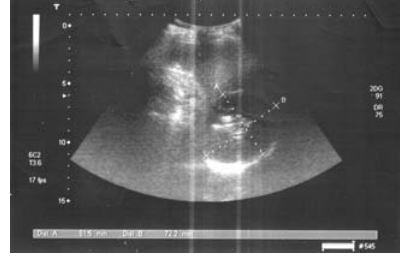
Figure 1. Ultrasound of the abdomen shows a hypoechogenic cystic structure in